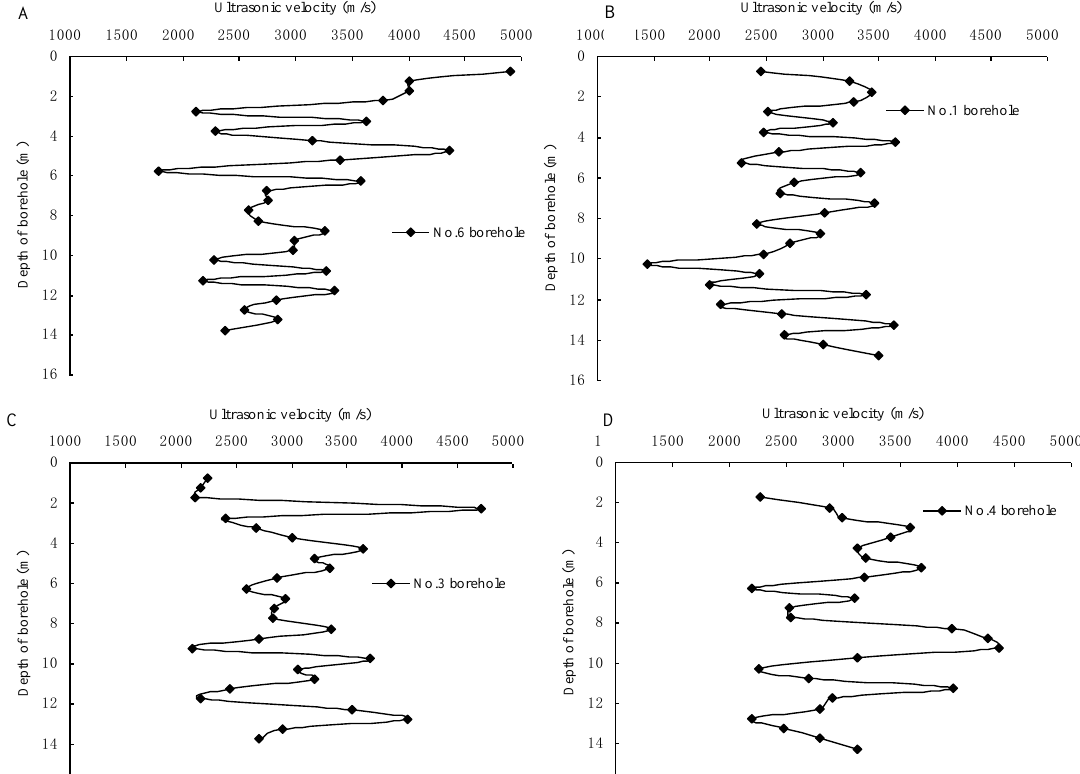
Figure 8. Relationship between ultrasonic velocity of RFC and depth.